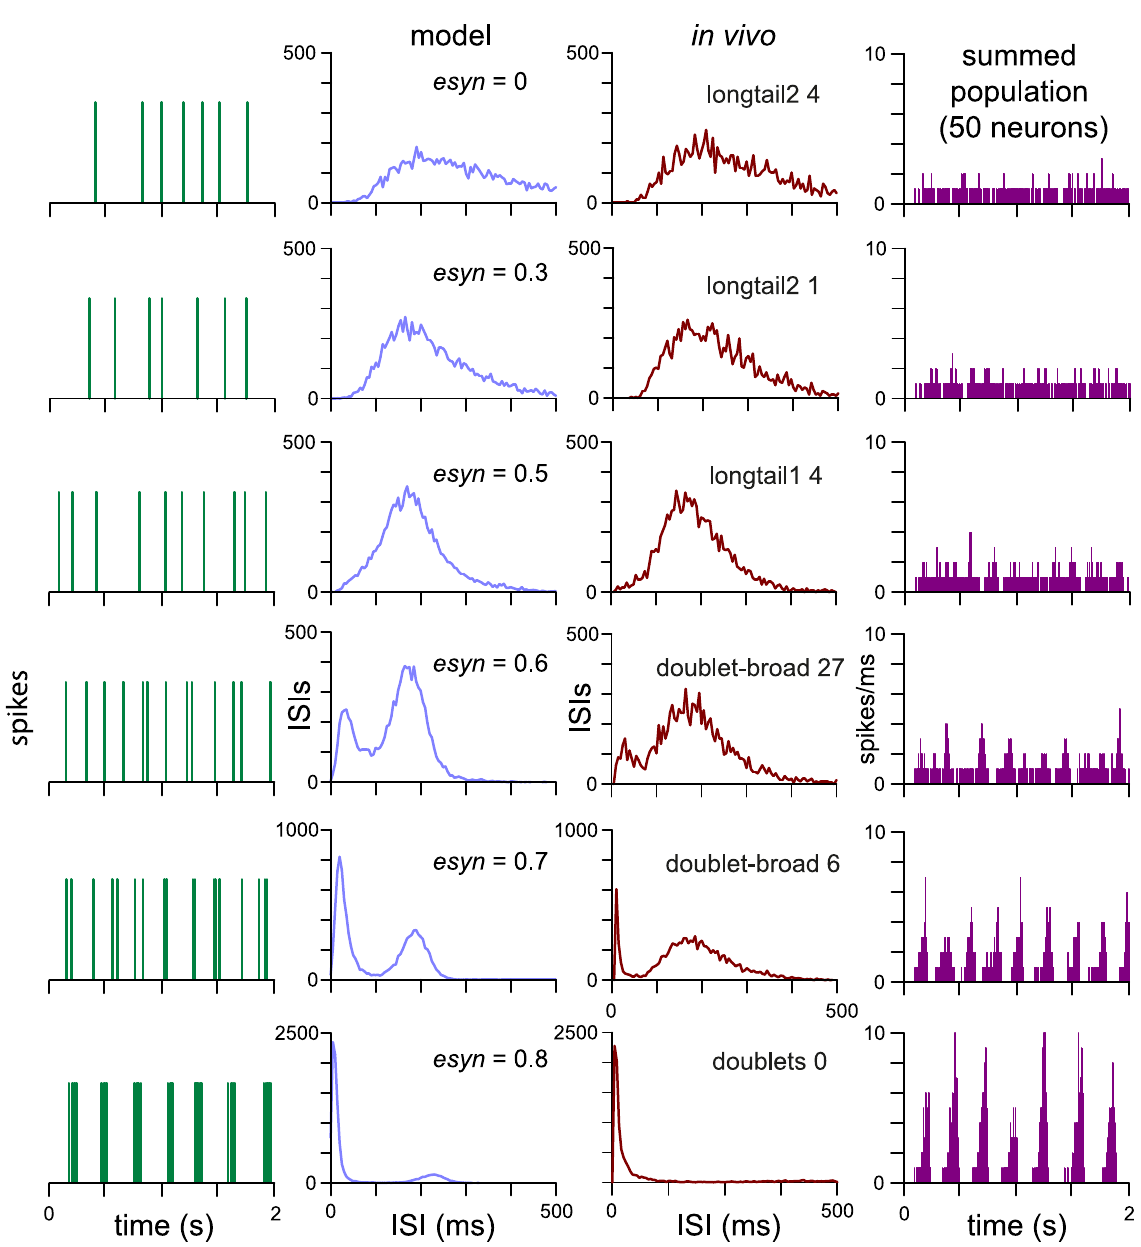
Fig 7. Increasing connection density in an excitatory ‘slow HAP’ network. Each row illustrates a single network model of 50 slow HAP neurons, with connection probability ( esyn ) increasing down the rows. All other neuron model parameters are fixed. The example data for 1 each network (1st and 2nd column) shows the spiking and ISI distribution for a typical single neuron. Neurons within each network model show very similar patterning, with some small variation due to the random connections and random external input signal. The in vivo column shows recorded VMN cells which have not been directly fitted, but which show patterning very similar to those of neurons in the corresponding network model. As esyn increases, the ISI distribution becomes less skewed and the amplitude of the mode increases until a 1 second mode appears, accompanied by the appearance of short bursts. As the second ISI mode grows and dominates, the bursts become faster and more regular, matching “doublet” type VMN cells. The population column (far right) shows the summed spiking activity of the 50 neurons. The noisy synchronisation of the network produces conical peaks that form